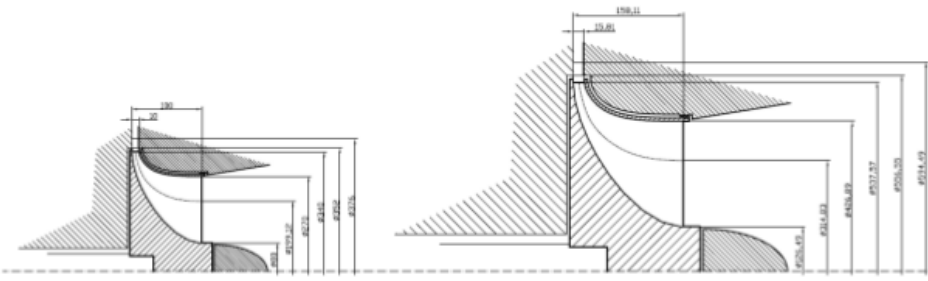
Figure 18: The comparison of the main dimensions of the 200 kW and 500 kW stages.